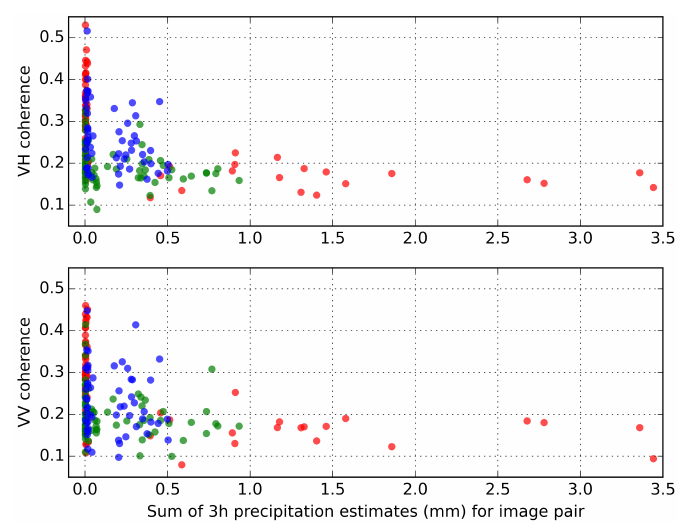
Figure 5. Scatterplot of coherence values and the sum of 3-h precipitation estimates at 300 m × 300 m spatial resolution based on weather radar data for the first image pair available within 12 days after a mowing event. R160 is represented by red, R80 by green, and R58 by blue dots.